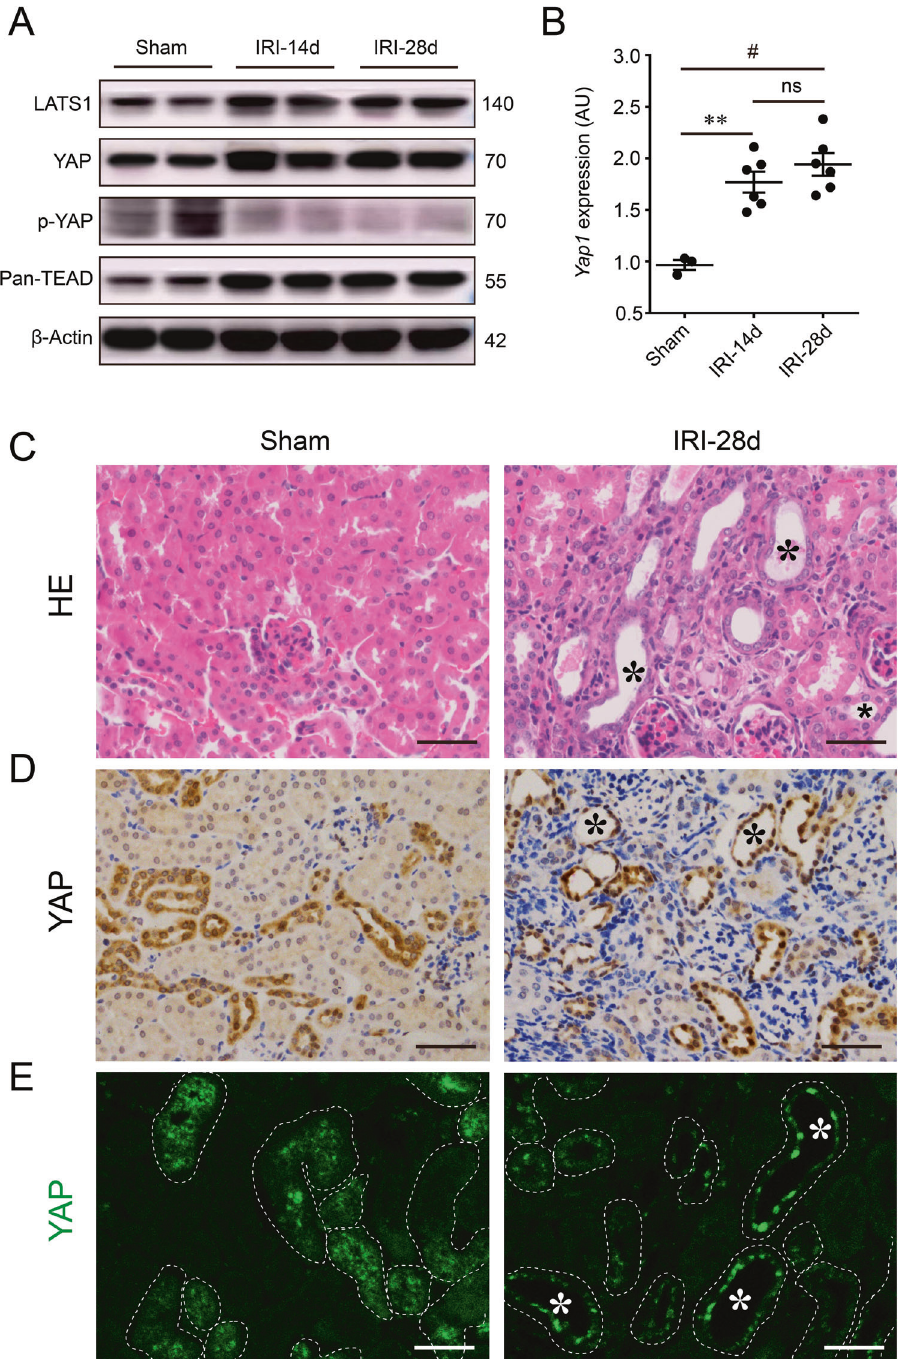
Fig. 2 Renal persistent activation Hippo-YAP pathway in response to AKI-induced maladaptation. A Renal expressions of LATS1, YAP, p-YAP (ser127), and TEAD in Sham, IRI-14d, and IRI-28d mice. Shown are representative blots from at least three separate experiments with similar results. B Renal mRNA level of Yap1 . AU arbitrary units. ( n = 3 for Sham and n = 6, 6 for IRI-14d and IRI-28d, respectively). C Representative images of renal cortex stained with HE. Asterisk represents pathological changes of tubular maladaptive repair in Sham and IRI-28d kidneys. D Representative images of immunohistochemistry and E immuno fl uorescent staining for YAP in Sham and IRI-28d kidneys. Asterisk represents the renal maladaptive-repaired tubules as well. Scale bar = 50 µm in all images of C , D , and E . All values are means ± SEM. ** p < 0.01 and # p < 0.001 are de fi ned as signi fi cant. ns not signi fi mouse (Supplementary Fig. S2A). In response to OGD/R stress, Western blot showed the protein expression of LATS1, YAP, p-YAP nuclear YAP distribution was increased, suggesting YAP transloca- (ser127), and TEAD in HK-2 was increased remarkably, which tion from cytoplasm to nucleus (Fig. 6C). In contrast, when HK-2 indicated activation of Hippo pathway after OGD/R stimulation was treated with VP, cellular YAP was primarily localized in the (Fig. 6B). Similar results were also found by using renal TEC from